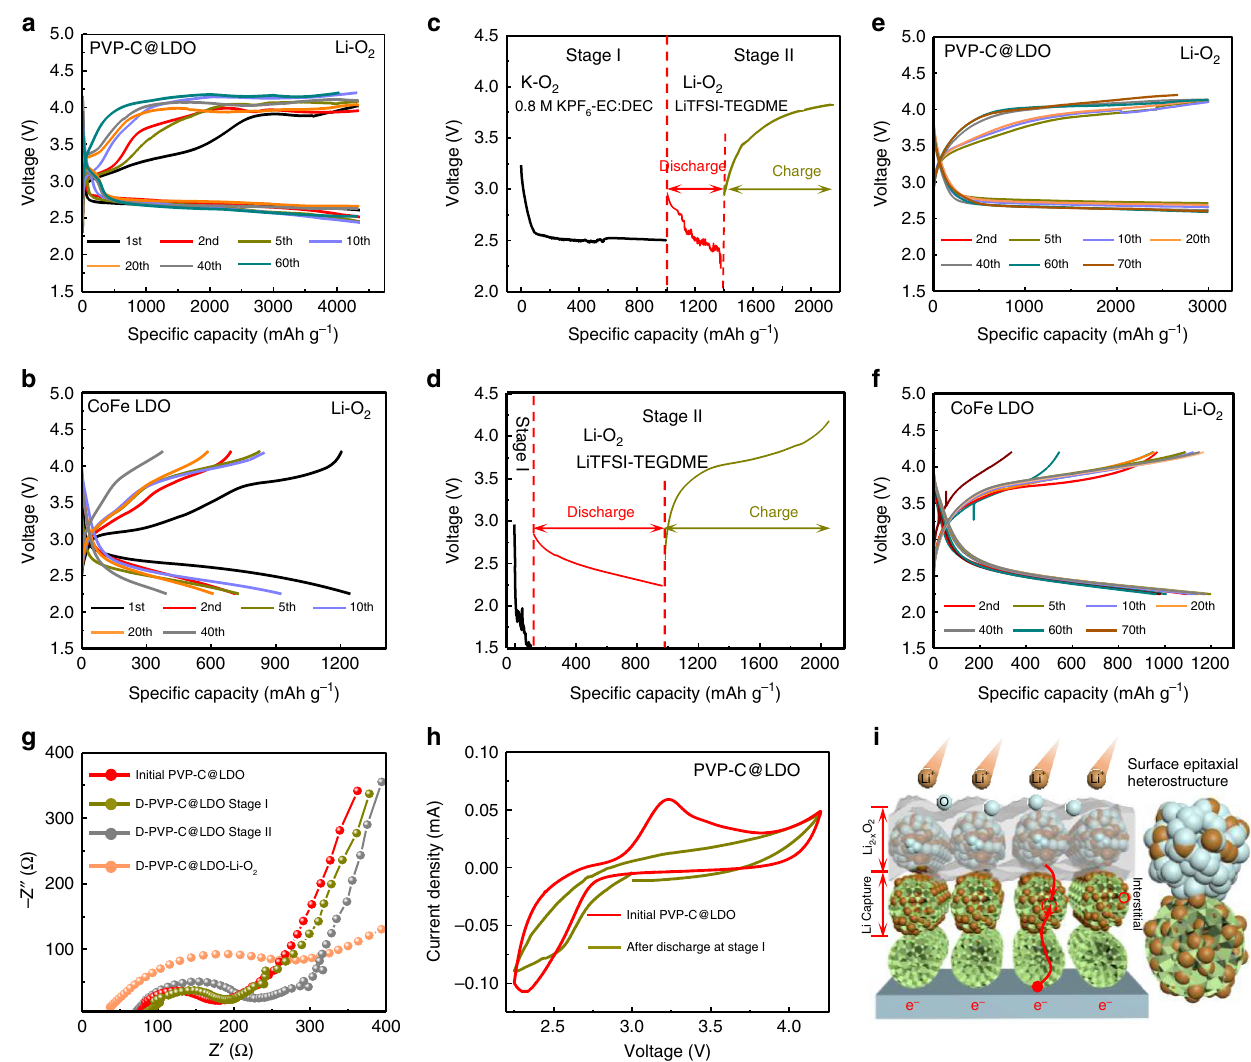
Fig. 2 Electrochemical performance. a , b PVP-C@LDO and CoFe LDO-based conventional Li – O 2 battery. c , d Multistaged pretreatment of PVP-C@LDO and CoFe LDO cathodes. Stage I: PVP-C@LDO/CoFe LDO|0.8 M KPF 6 -EC: DEC (1:1)|K. Stage II: PVP-C@LDO/CoFe LDO|1M LiTFSI-TEGDME|Li. e , f Cycling performance of PVP-C@LDO and CoFe LDO after multistaged discharge. Current densities are 100 mA g − 1 . g , h Nyquist plots and cyclic voltammetric (CV) curves of PVP-C@LDO before and after discharge at a stage I and stage II. i Schematic representation of the formation of fi lm-like Li 2 − x O 2 after multistaged